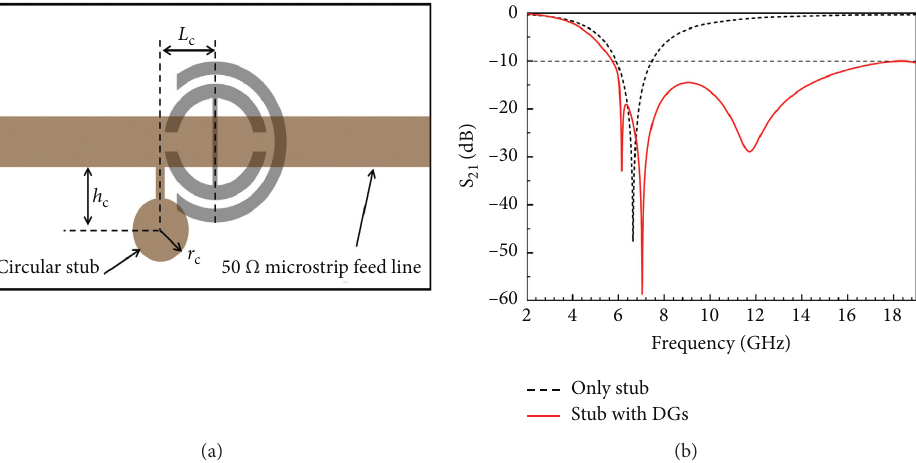
Figure 2: Simulated current distribution of the conventional patch antenna and newly designed patch antenna: (a) TM (b) TM 20 ( f � 6.12GHz), (c) TM 30 ( f � 9.28GHz), (d) TM 04 ( f � 12.49GHz), (e) TM 50 ( f � 15.41GHz), and (f) TM 60 ( f � 18.65GHz).